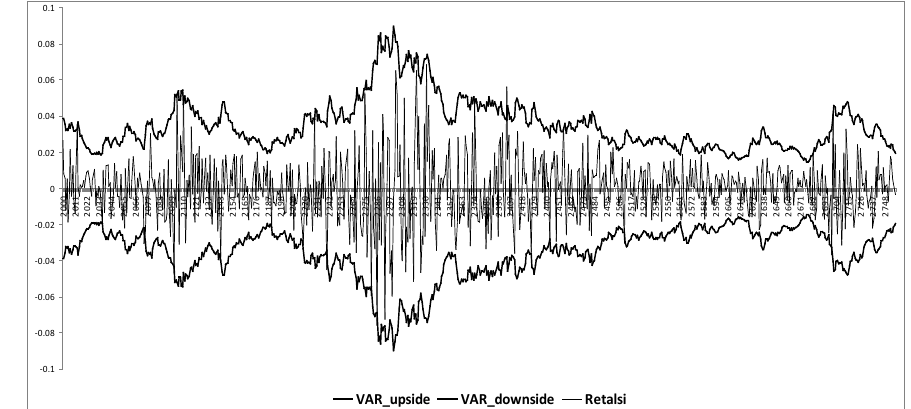
FIGURE 3: Garch-N Source: Authors’ calculations, based on JSE ALSI return series